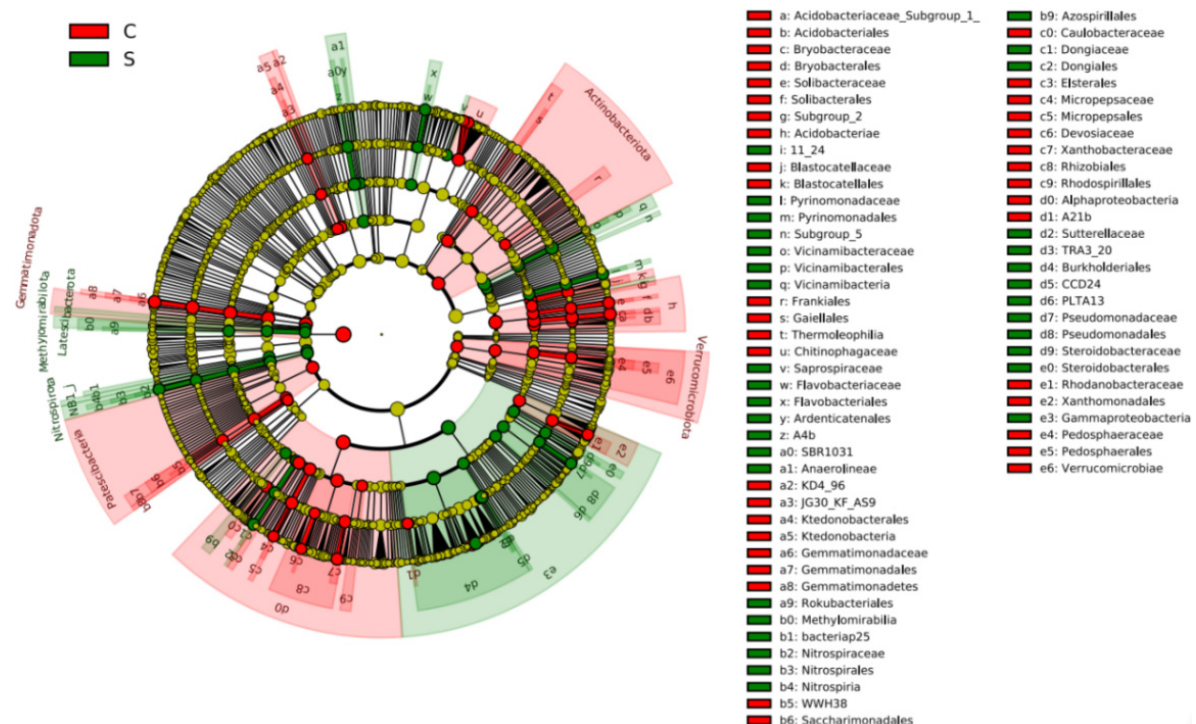
Figure 8. Cladogram depicting the taxonomic levels, from the phylum to the species. Each small circle at a different taxonomic level represents a taxonomic unit at that level. Red nodes denote the rhizosphere microbial groups that play an important role in nursery cultivated tallow trees. The green nodes indicate the microbial groups that have important associations with saline-alkaline environments. Yellow nodes represent the microbial groups that do not play an important role in both groups.